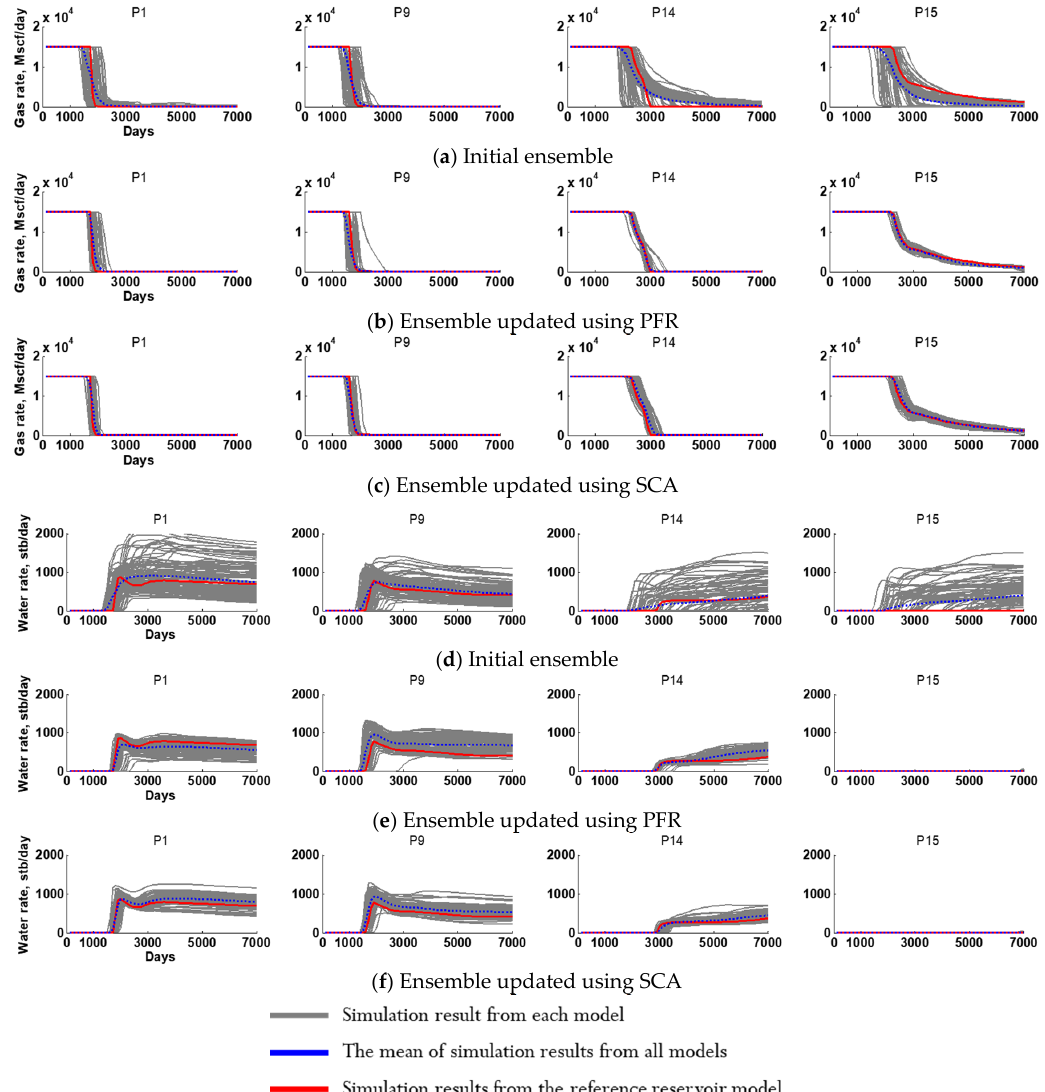
Figure 11. Gas and water well production rates of initial ensemble and updated ensembles using PFR and SCA.